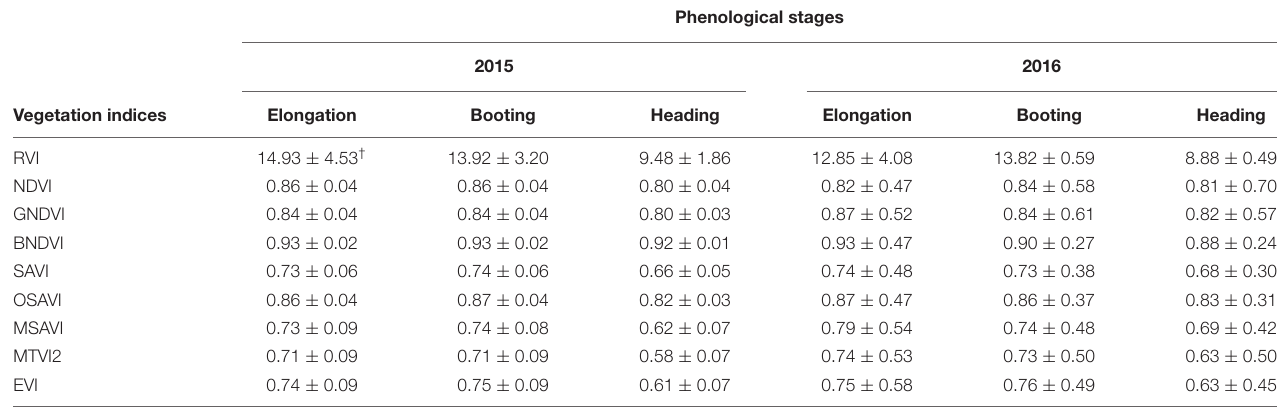
TABLE 4 | Relationship of vegetation indices to the phenological stages in 2015 and 2016.